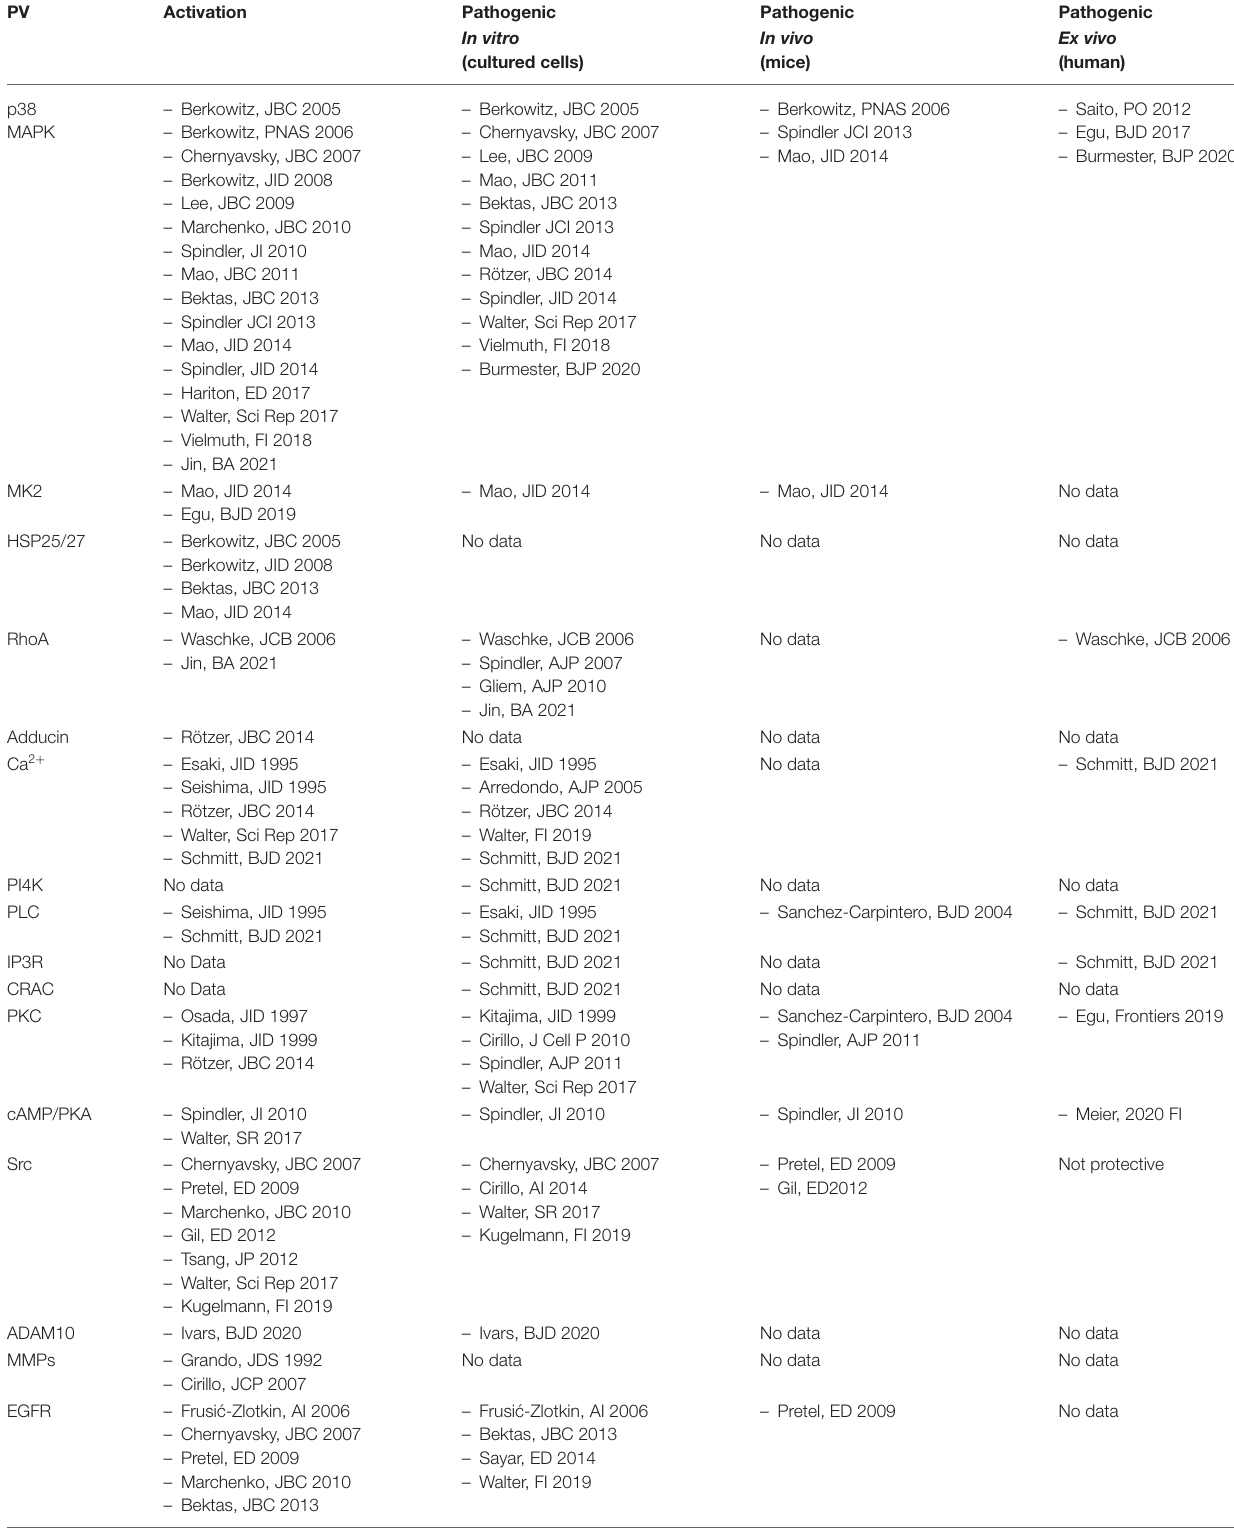
TABLE 2 | Studies on signalling pathways in